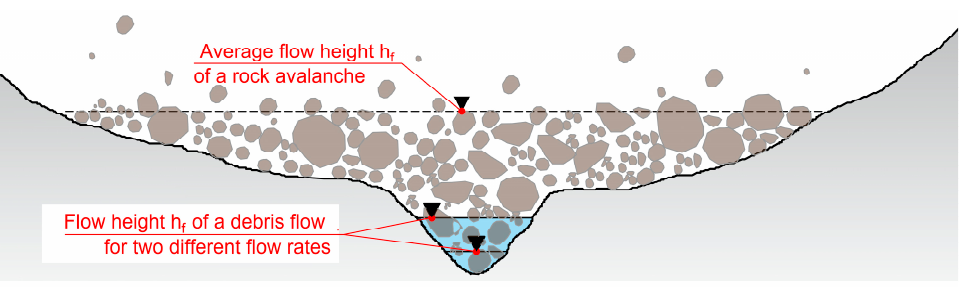
Figure 6. Cross section with flow height through a possible debris flow and rock avalanche.